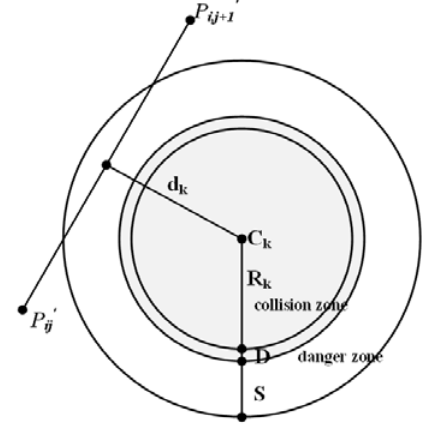
Figure 1. Threat. Figure 1.